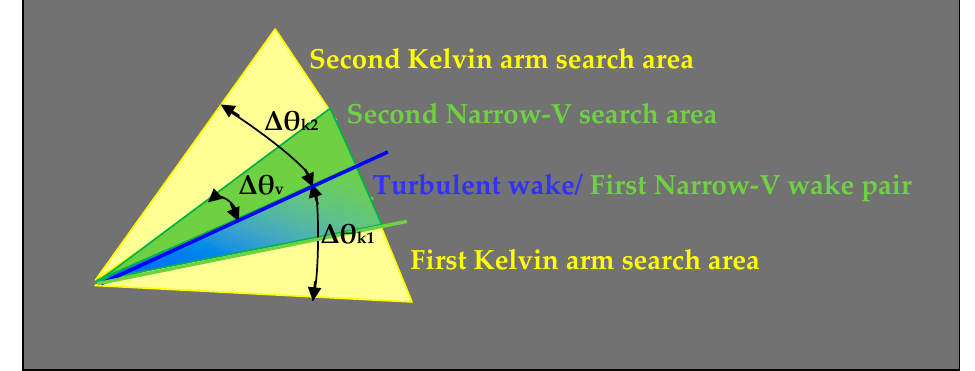
Figure 2. Angular search logic for narrow-V wakes and Kelvin arms. Table 1. Search logic for the second narrow-V wake.